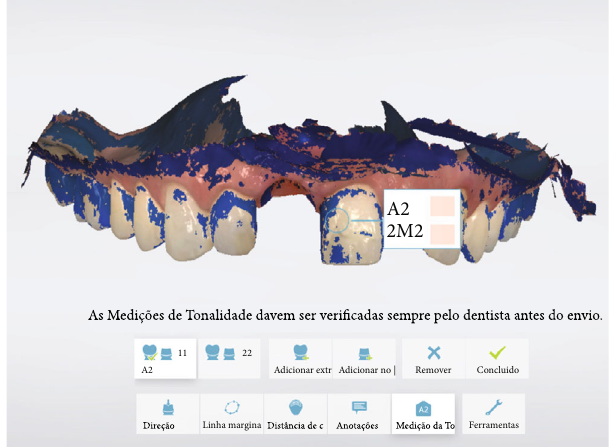
Figure 8: Selection of the fi nal crown shade using the intraoral